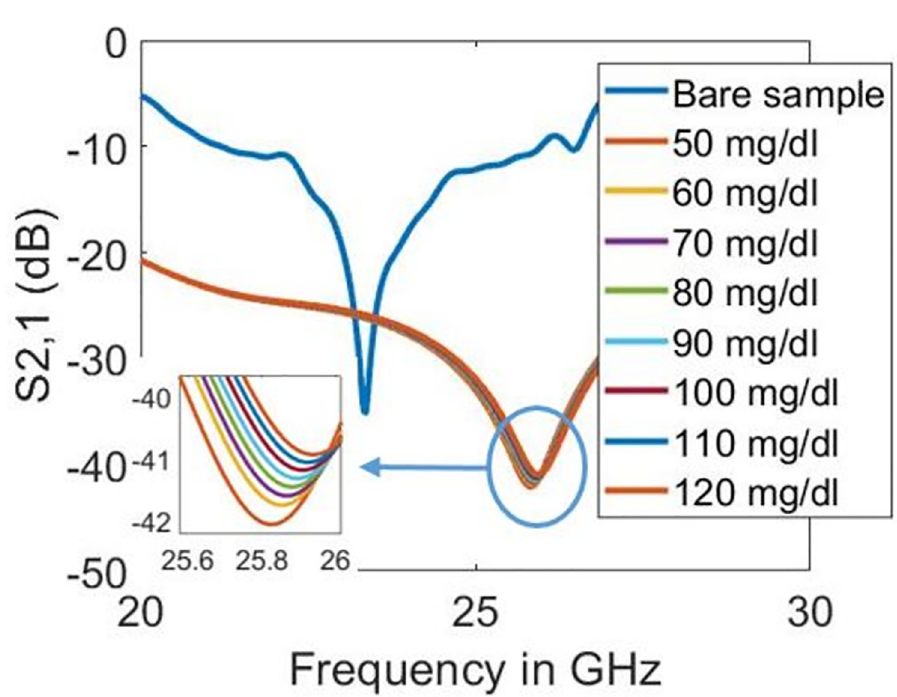
Fig 14. Transmission coefficient responses on different glucose levels with three split-rings.